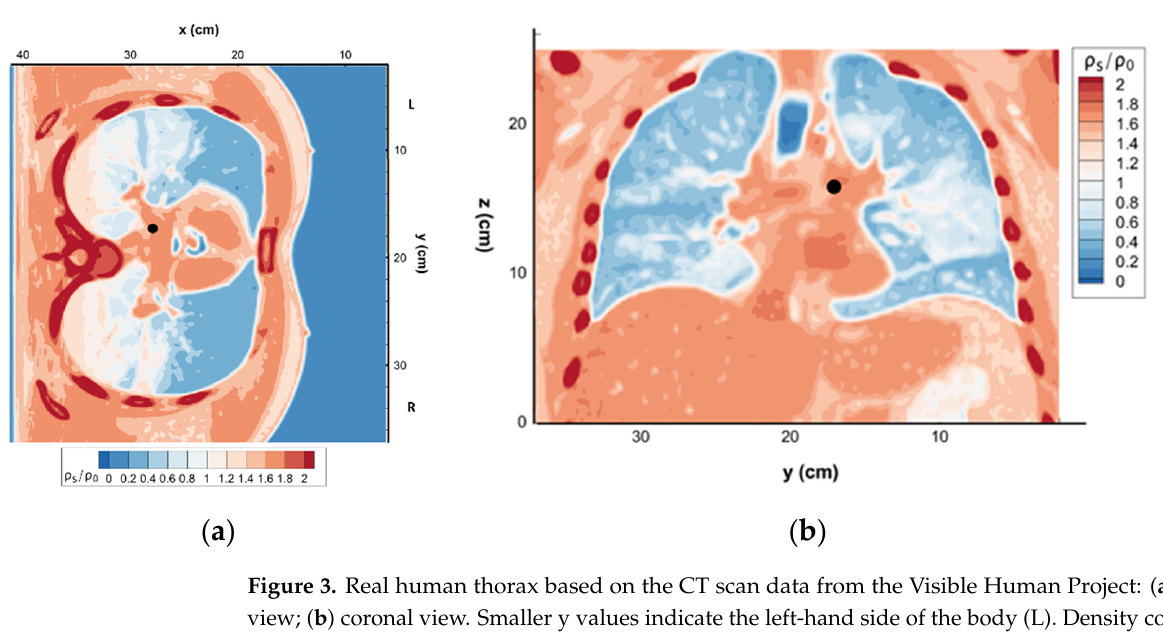
Figure 3. Real human thorax based on the CT scan data from the Visible Human Project: ( a ) axial view; ( b ) coronal view. Smaller y values indicate the left-hand side of the body (L). Density contours obtained from this imaging were used to determine the location where the murmur source (atrium) is located. The black spot marks the source location.